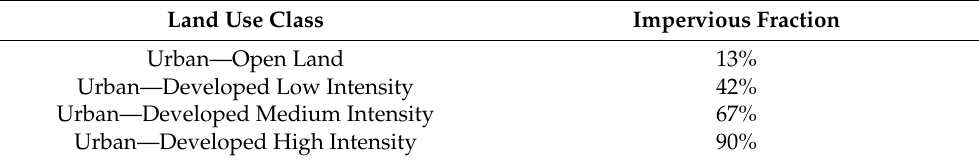
Figure 2. Land Use in model domain with USGS land classes edited to include more detailed urban sub–classes. Table 1. Impervious fraction of urban land use classes in the LA metropolitan area. Land Use Class